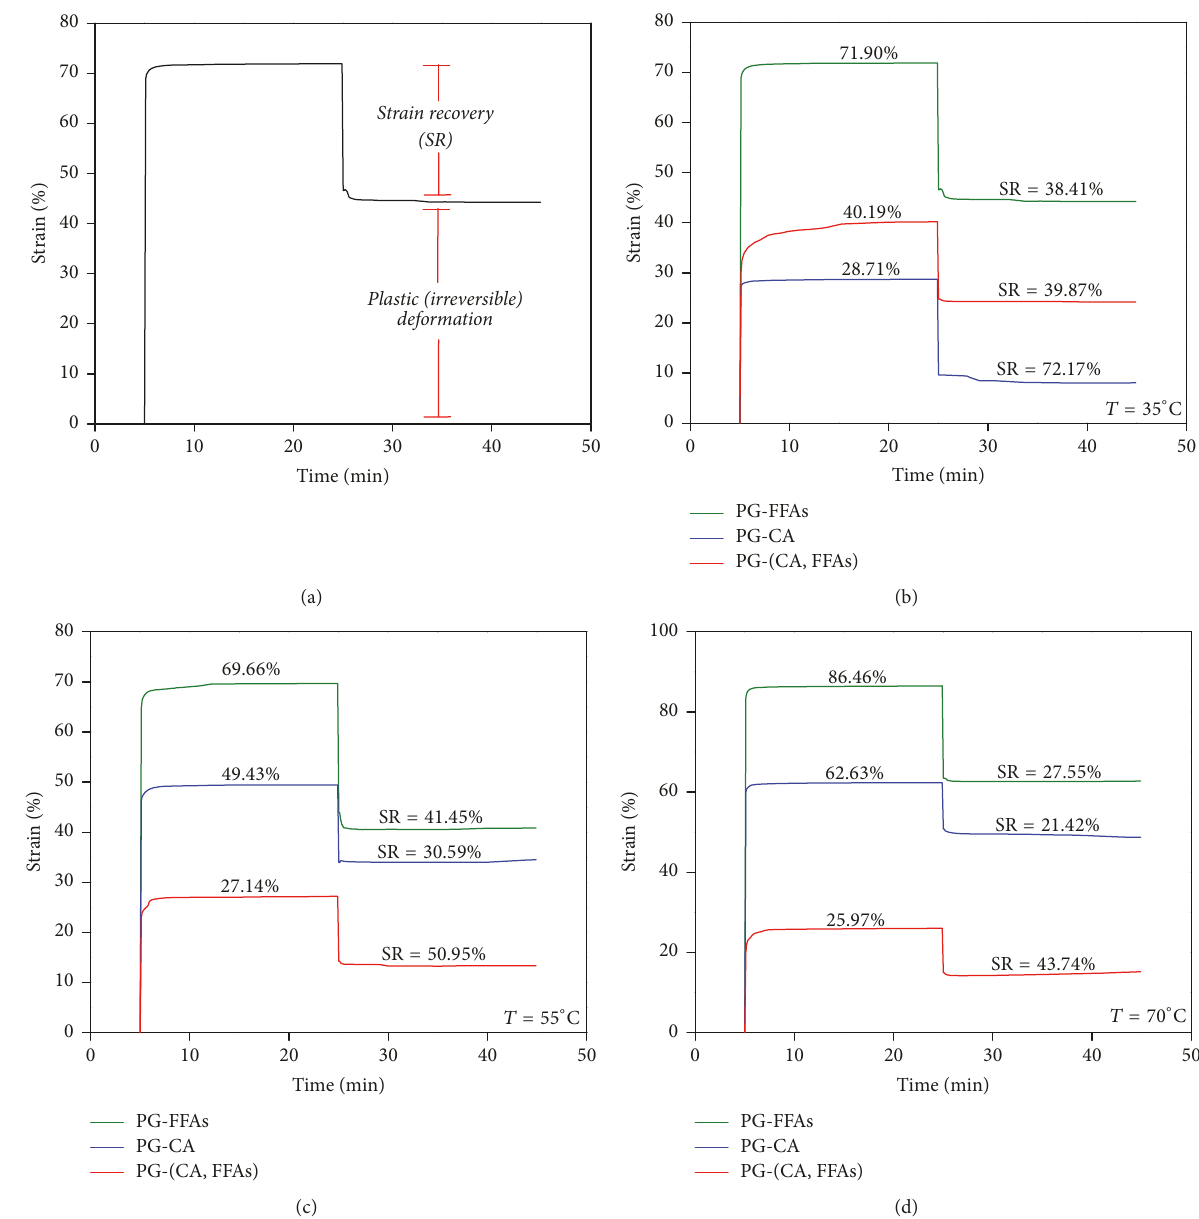
Figure 5: Submersion-compression creep for treatments PG-FFAs, PG-CA, and PG-(CA, FFAs) in DMA at 35 ∘ C, 55 ∘ C, and 70 ∘ C.